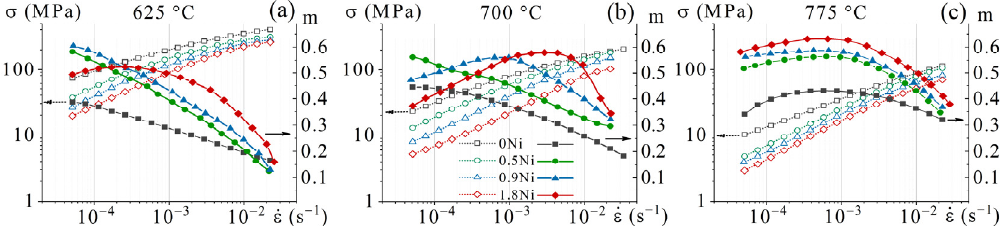
Figure 6. Stress vs. strain rate and m value vs. strain rate obtained by a step-by-step decrease in the strain rate at ( a ) 625 °C, ( b ) 700 °C, and ( c ) 775 °C. Uniaxial constant strain rate tests were carried out at temperatures of 625, 700, and 775 °C and at a strain rate of 1 × 10 − 3 s − 1 (Figure 7), which corresponded to a high m coeffi- cient. Alloying with 0.9–1.8 wt.% Ni decreased flow stresses by 2–3-fold and increased the elongation to failure from 200–350% to 500–950%. The alloy with 0.5 wt.% Ni exhibited the maximum elongation of 700% at 775 °C. The deformation temperature of 775 °C pro- vided the lowest stresses and the highest elongation to failure of the studied alloys. Figure 7c demonstrates the stress–strain curve for the 1.8Ni alloy hot-rolled at 700 °C. The elon- gation to failure decreased, and the flow stress increased as a result of the Ti 2 Ni phase precipitation that occurred when the hot working temperature was lowered to 700 °C.